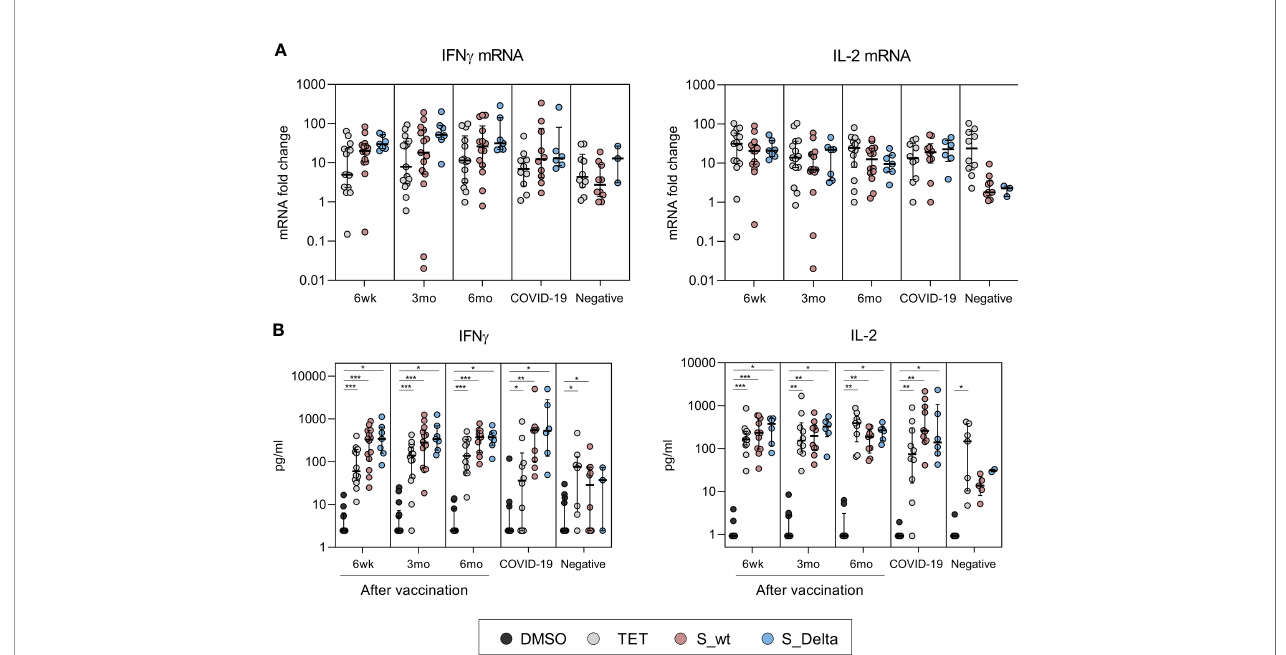
FIGURE 4 | Cytokine mRNA expression in PBMCs and secretion of cytokines after stimulation with SARS-CoV-2 spike-speci fi c peptides. Cytokine analysis was performed for PBMCs collected from BNT162b2 vaccinated HCWs 6 weeks (n=15), 3 months (n=15), and 6 months (n=14) after the fi rst vaccine dose and from convalescent COVID-19 patients (n=10) and negative controls (n=10). PBMCs were treated with DMSO or stimulated with tetanus toxoid (10 µg/ml), SARS-CoV-2 wt or Delta S protein peptide pools (0.5 µg/ml) for 48h. Delta variant S peptide stimulation was performed to 7/15 vaccinated, 6/10 COVID-19 patients, and 3/10 negative controls. Cells and supernatants were collected, and total cellular RNA was isolated from stimulated cells. (A) IFN- g and IL-2 mRNA expression was quantitated from total cellular RNA with RT-qPCR and the data is presented as fold change in comparison to DMSO treated cells. (B) Secreted cytokines (IFN- g and IL-2) were analyzed with multiplex immunoassay from PBMCs. IFN- g measurement was unsuccessful from 1 6wk-sample, 1 3mo-sample, and 3 6mo-samples stimulated with DMSO or S_wt. IL-2 measurement was unsuccessful from 3 6wk-samples, 5 3mo and 6mo-samples, and 3 negative samples stimulated with DMSO or S_wt. Data is represented as median and interquartile range. Statistical analysis was performed by Wilcoxon signed rank test for comparison of wt S peptide pool stimulations with Delta S peptide pool stimulations (A, B) and tetanus and SARS-CoV-2 wt and Delta S peptide pool stimulations with DMSO control (B) . Samples with no data on both data points were excluded from analysis. *p < 0.05; **p < 0.01; ***p <